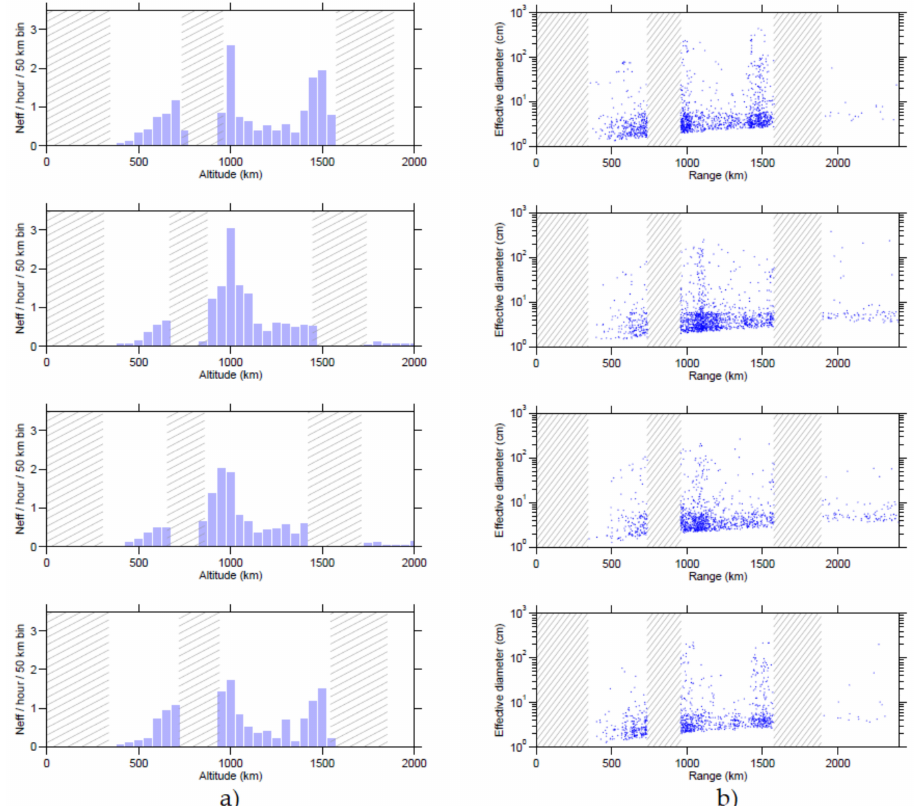
Figure 18. Summary plot of the Cp2 campaign (7–29 September 2005) for 4 different antenna positions: altitude vs. effective event rate ( a ) and range vs. effective diameter ( b ) [35]. Reproduced with permission from Markkanen, J., Small-Size Space Debris Data Collection with EISCAT Radar Facilities; Final Report of ESOC Contract 18575/04,